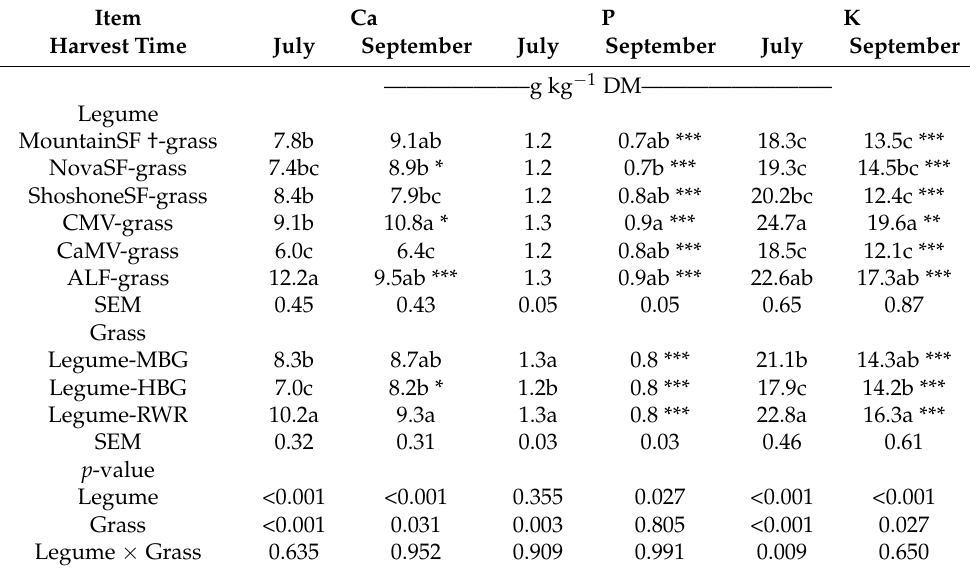
Table 6. Mineral composition of legume-grass binary mixtures at July and September harvest at Saskatoon, Saskatchewan, Canada.